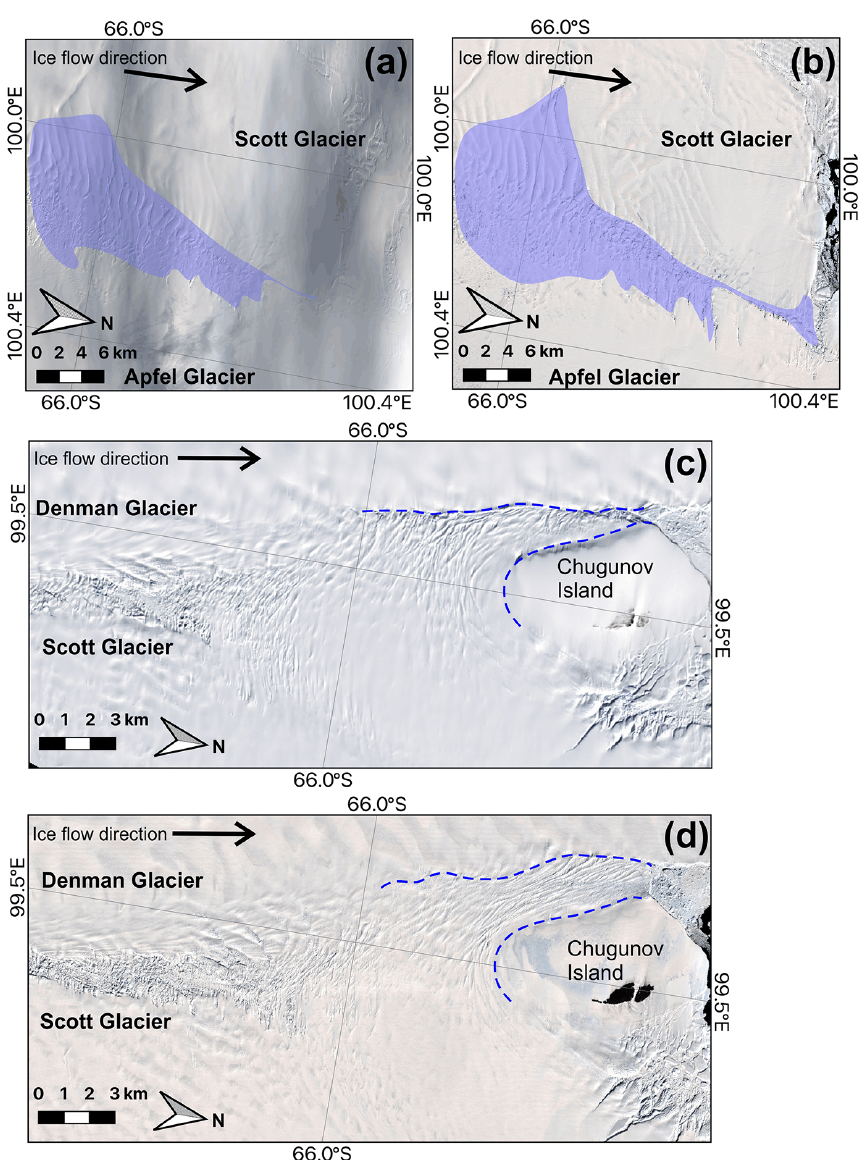
Figure 6. (a) The 2015 extent of the Scott–Apfel glacier shear margin highlighted in blue (background Landsat 8 OLI acquired on 25 March). (b) The 2021 extent of the Scott–Apfel glacier shear margin highlighted in blue (background: Sentinel 2B 13 February 2021). (c) Scott– Denman glacier shear margin in 2015, the dashed blue line highlights the position and shape of the margin (background: Landsat 8 OLI acquired on February 2015). (d) The Scott–Denman glacier shear margin in 2021, the dashed blue line highlights the widening of the shear margin into the Denman Glacier (background: Sentinel 2B acquired on 27 February